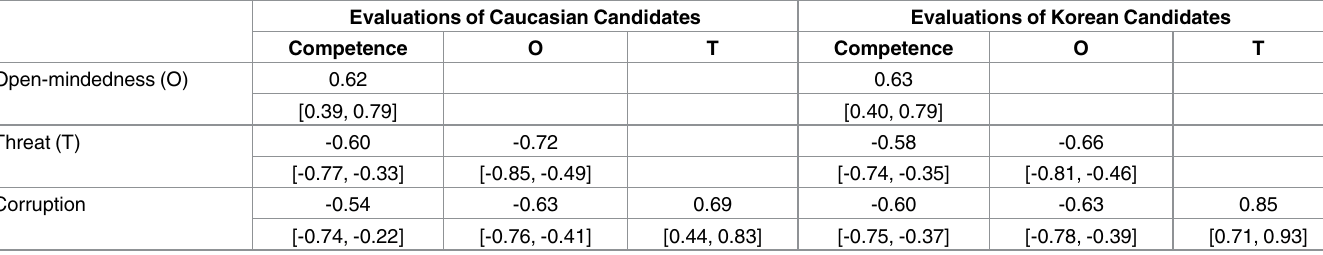
Table 1. Spearman correlations between aggregate inferences of different